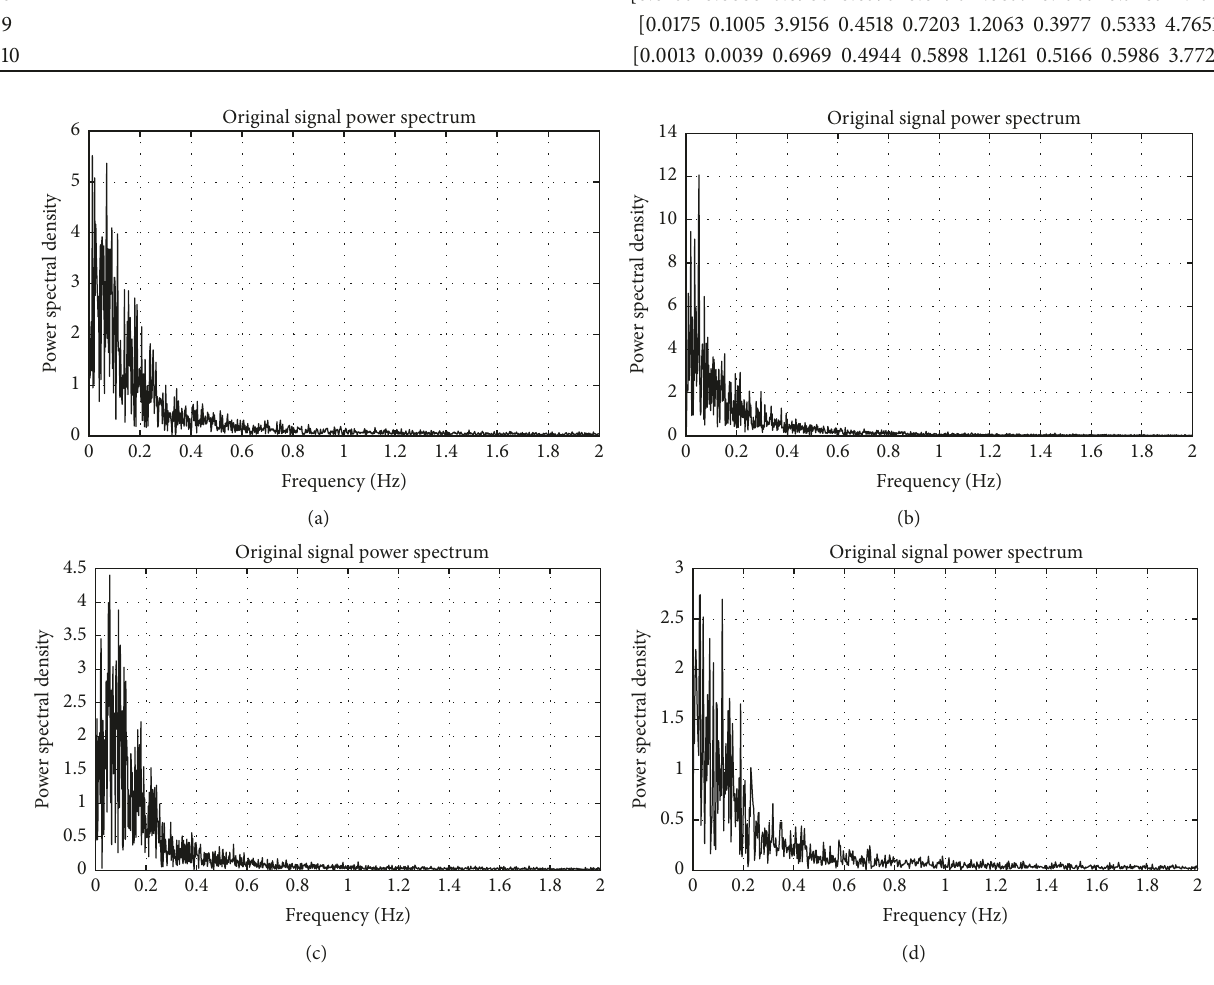
Figure 3: Power spectrum distribution of electrical signals in maize leaf under osmotic stress. (a) The normal growing condition; (b) the mild drought stress; (c) the moderate drought stress; (d) the severe drought